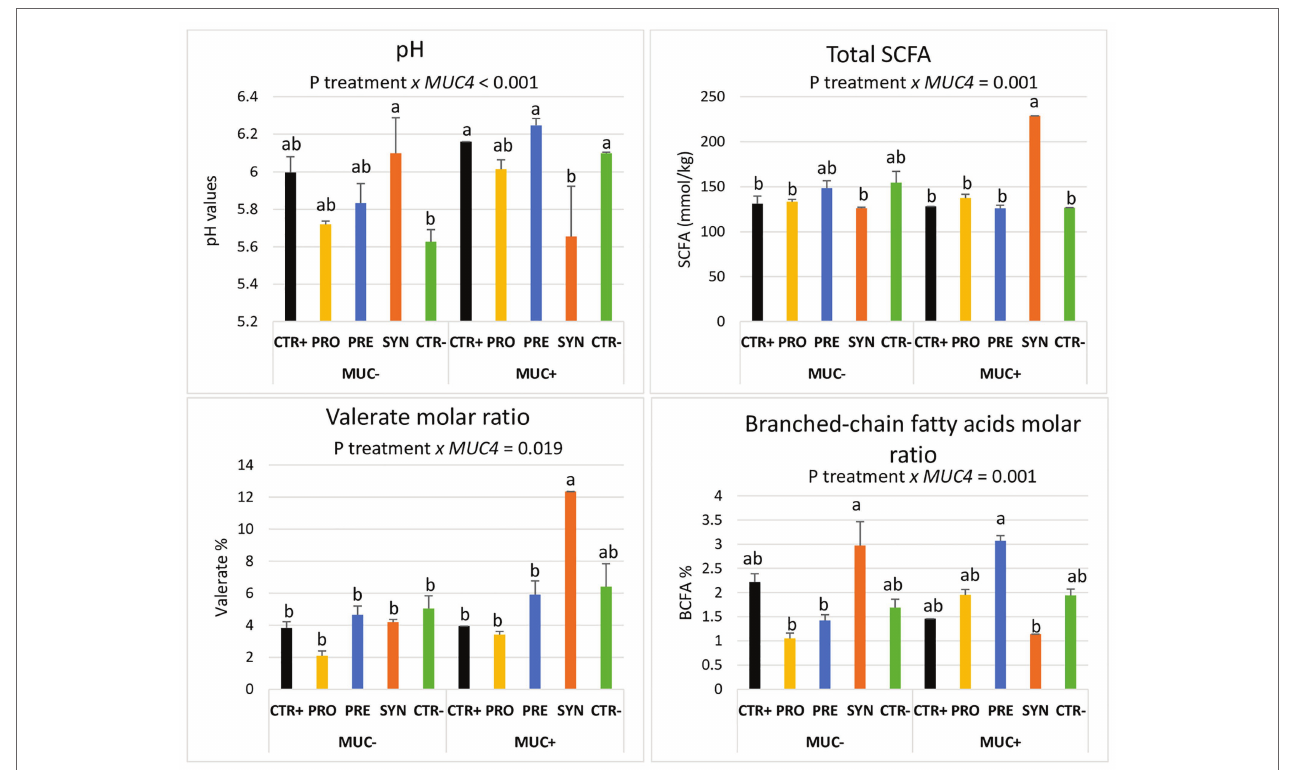
FIGURE 5 | Interactions between MUC4 gene polymorphism and diets on pH values, total short-chain fatty acids (SCFA), valerate molar ratio, and branched-chain fatty acids molar ratio (BCFA) on day 8 PI. CTR+: non-inoculated animals receiving placebo; PRO − : inoculated animals receiving the probiotics; PRE − : inoculated animals receiving the prebiotic; SYN − : inoculated animals receiving the synbiotic; CTR − : inoculated animals receiving placebo. N = 6 for all groups except for non-challenged animals ( N = 8). MUC4 represents the effect of polymorphism of the MUC4 gene. a and b indicate statistically significant differences between groups. Bars correspond to standard error. BCFA, branched-chain fatty acids; MUC4 +, Mucin 4 susceptible genotype; MUC4 − , Mucin 4 resistant genotype; SCFA, short-chain fatty acids.